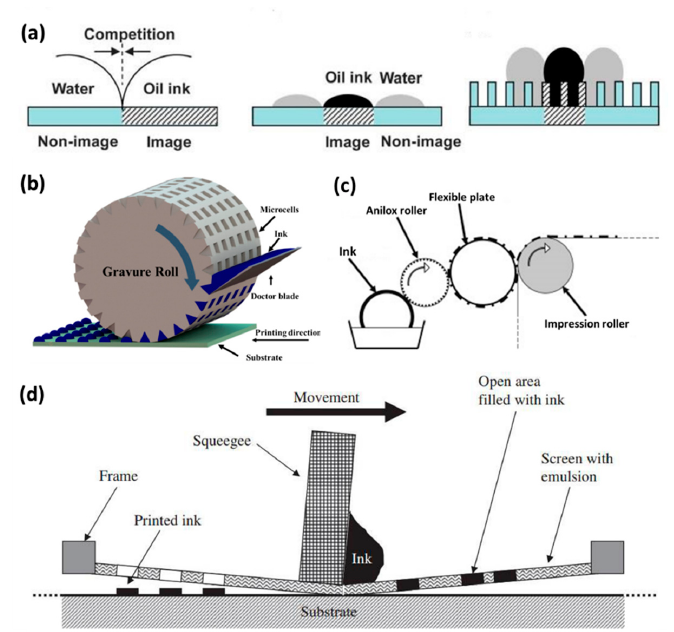
Figure 1. ( a ) The scheme is the role of plate for controlling ink patterning in offset printing technique. The hydrophilic area is the non-image area, and the other area is the image area. The effect of surface energy and surface structure on the wetting behavior of oil ink and water are exhibited. The water is on the hydrophilic and non-image area which could repel the oil ink. The plate is the chemically patterned flat plate. The plate is the chemically and structured patterned plate. Reproduced from [33], with permission from Royal Society of Chemistry, 2013; ( b ) The processing steps of gravure printing: ink filling in the microcells, the doctor blade wiping the ink, ink transferring to the substrate, the functional material patterning formation. Reproduced from [35], with permission from American Chemical Society, 2014; ( c ) The processing steps of flexographic printing: ink transferring to the anilox roller, ink transferring to the flexible plate, ink transferring to the substrate with the impression roller; ( d ) The processing steps of screen printing. The ink is squeezed through the pores from the mesh plate with the auto device, and then the functional ink is deposited onto the required area of printing substrate. Reproduced from [40], with permission from Elsevier, 2009.